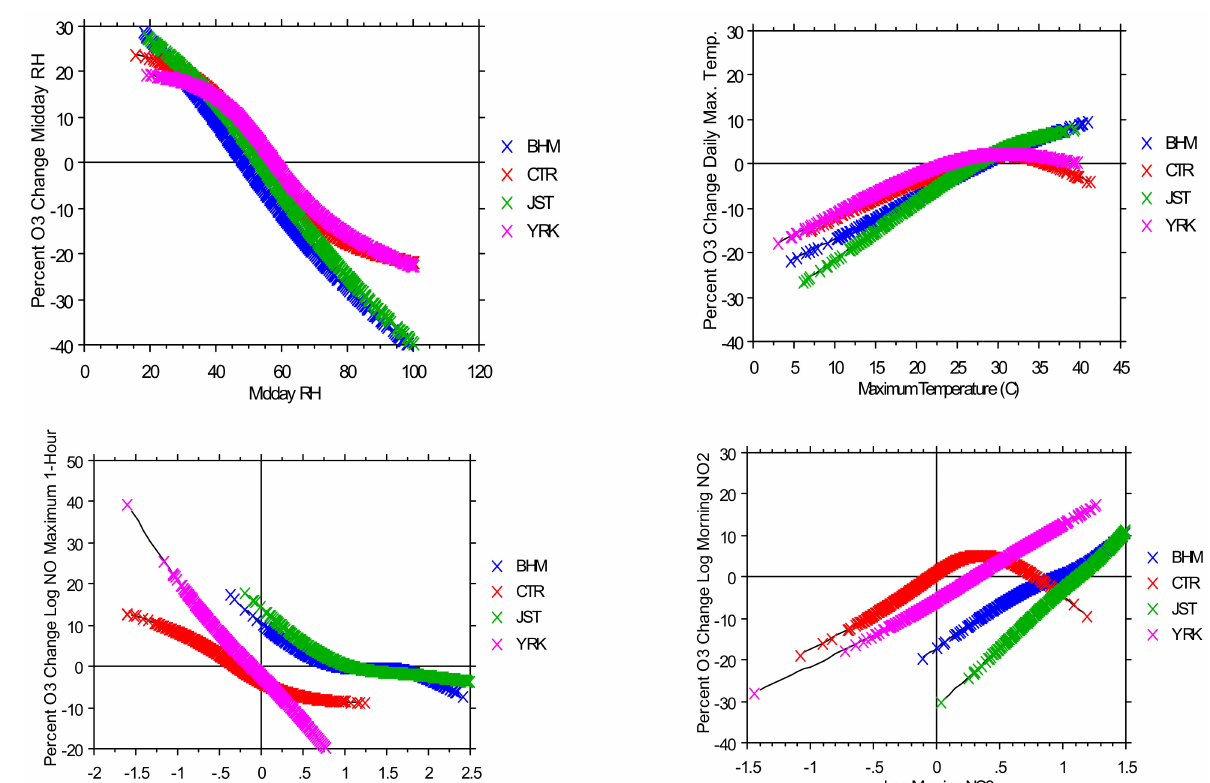
Figure 5. Estimation of the chemistry meteorology interactions for ozone derived from the application of a generalized additive model on a large data set in southeastern U.S. BHM is Birmingham, Alabama; JST is Atlanta, Georgia; rural sites are CTR (Centreville, Alabama) and YRK (Yorkville, Georgia)